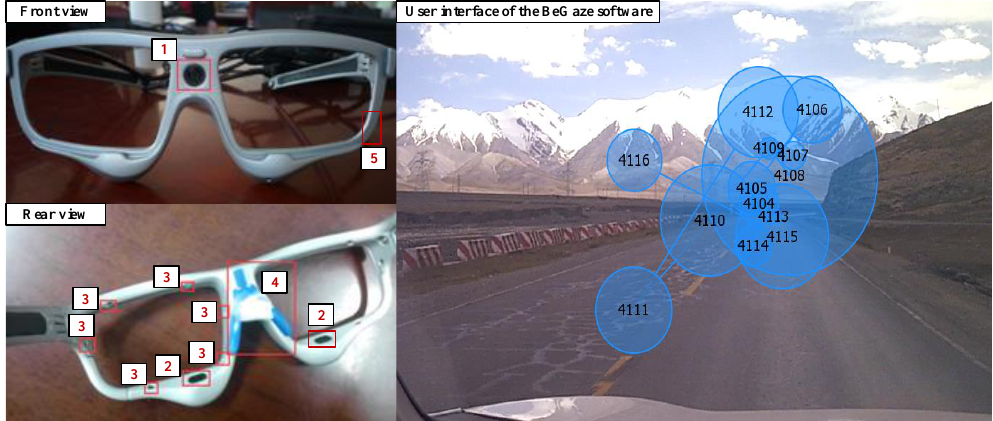
Figure 4. Sensors on the SMI ETG2w system and data processing interface.